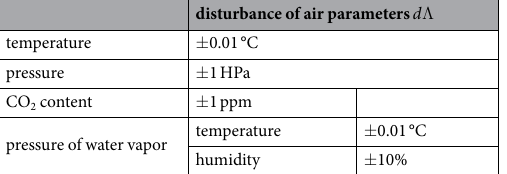
where t c , p c , x c , and p wc represent the temperature, pressure, CO 2 concentration and the pressure of water vapor in the correction arm, respectively. Substituting n λ ic from Equation (11) into Equation (10), the result is approximately: ≈ Equation (10) can rewrite as: